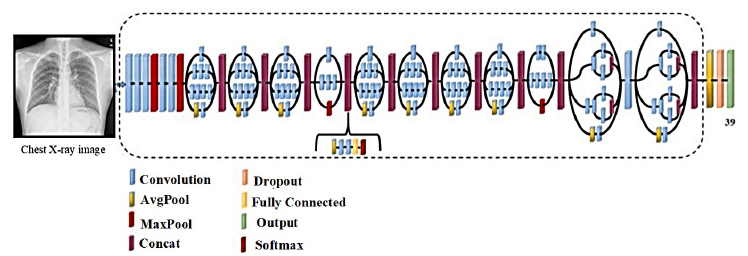
Figure 6. Schematic illustration of the Inception V3